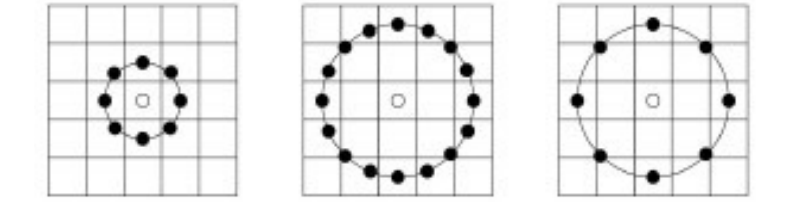
Figure 2. The circle LBP operators. ( Left ): R = 1.N = 8; ( Middle ): R = 2, N = 16; ( Right ): R = 2, N =